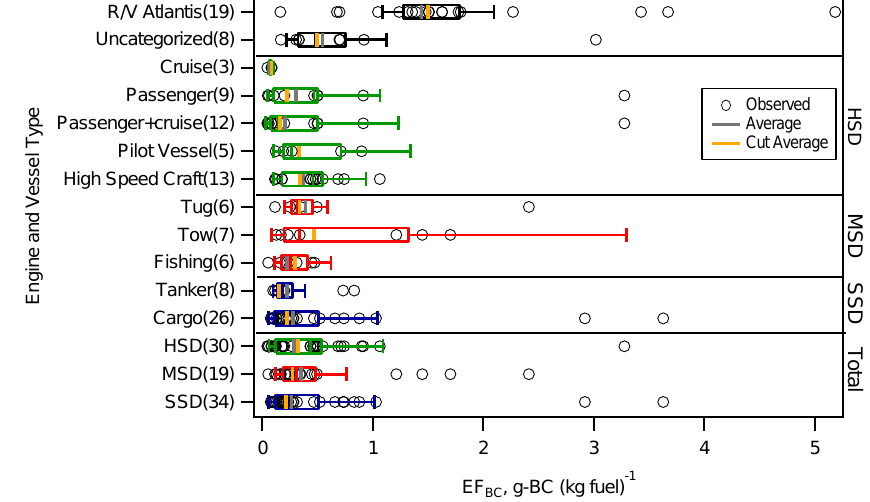
Fig. 4. Boxplots of EF BC categorized by engine type and AIS vessel type. The open circles are the weighted average EF BC determined for each vessel encounter. The boxes define the interquartile range, i.e. the middle 50% of the data. Whiskers of the boxplots are 3 times the interquartile range, and any emission factors lying outside these whiskers are considered “outliers”. The median EF BC ’s are the vertical lines with the same colour as the box; the geometric average EF BC ’s are the vertical, grey lines; and the geometric cut-average EF BC ’s are the vertical orange lines. Where the average and cut average are equal, only the cut average is seen. The number of ship encounters is listed in parentheses for each engine or vessel